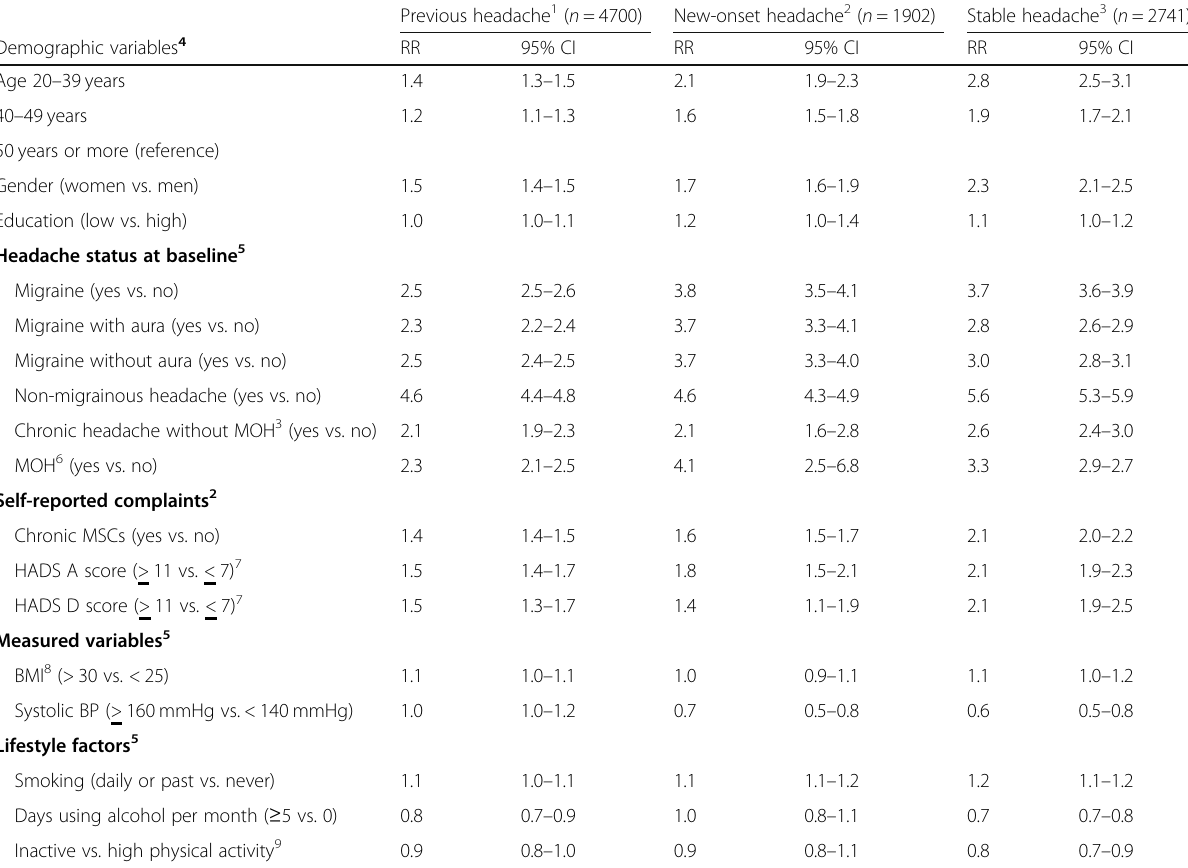
Table 4 Poisson regression was used to evaluate baseline variables in HUNT2 and risk ratios (RRs) of headache status 22 years later in HUNT4 in persons who participated in all three surveys (n = 16,118). Precision of the estimates was assessed by 95% confidence interval (CIs). Reference group in all three headache status groups consisted of participants without headache in all three surveys ( n =